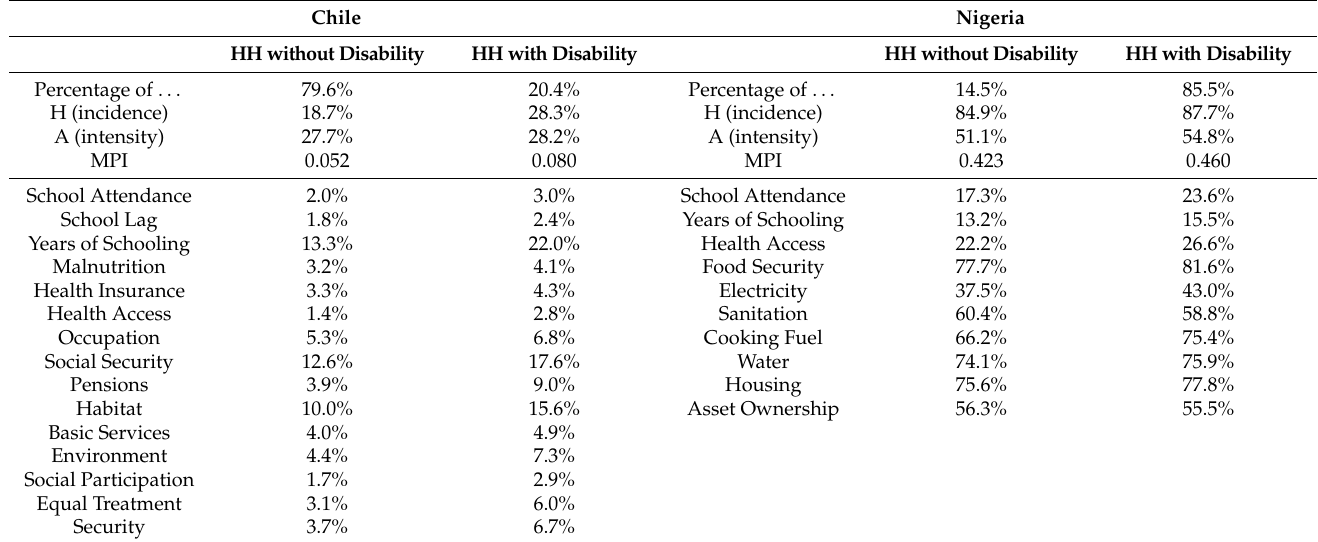
Table 1. Incidence, intensity, MPI, and censored headcount ratios a by disability status of households in Chile and Nigeria.